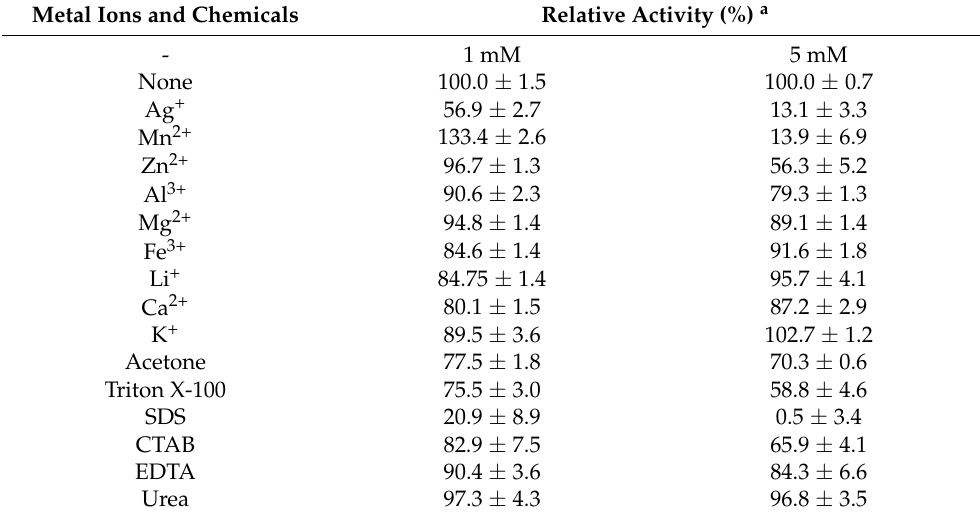
Table 2. Effect of various metal ions or chemical reagents on the activity of AfCel5A.